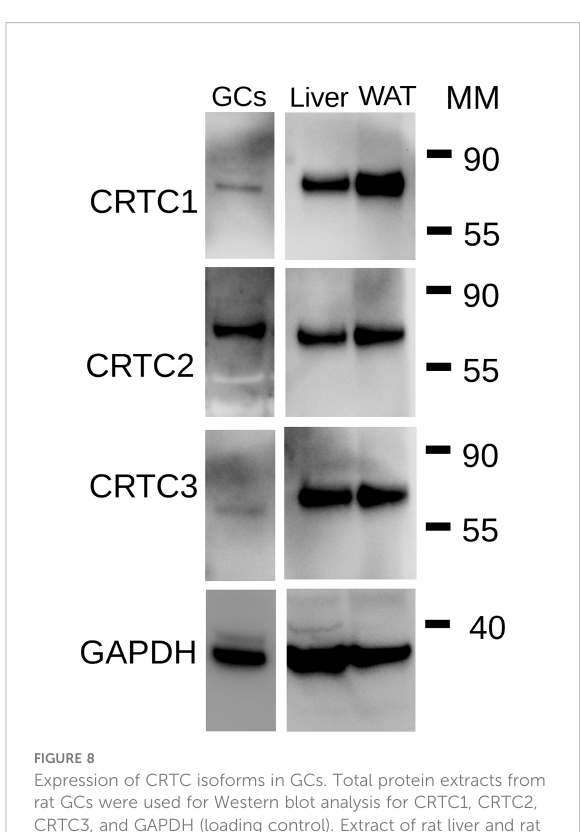
FIGURE 8 Expression of CRTC isoforms in GCs. Total protein extracts from rat GCs were used for Western blot analysis for CRTC1, CRTC2, CRTC3, and GAPDH (loading control). Extract of rat liver and rat white adipose tissue (WAT) were used as positive controls. MM: Molecular Marker weight in kDa. Representative blot of two individual